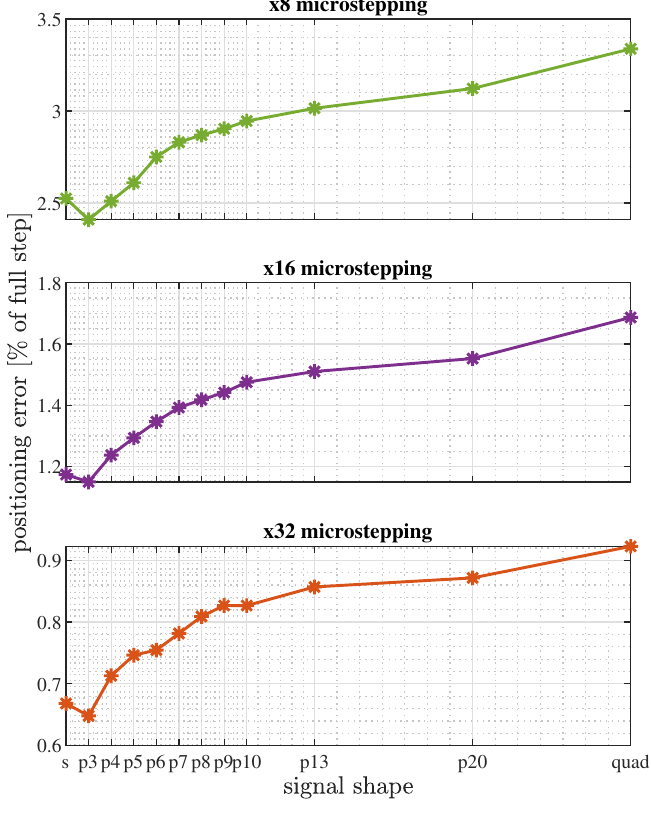
Figure 27. Positioning error against signal shape for different microstepping resolutions. Error calculated only from experiments in which load was applied to the motor